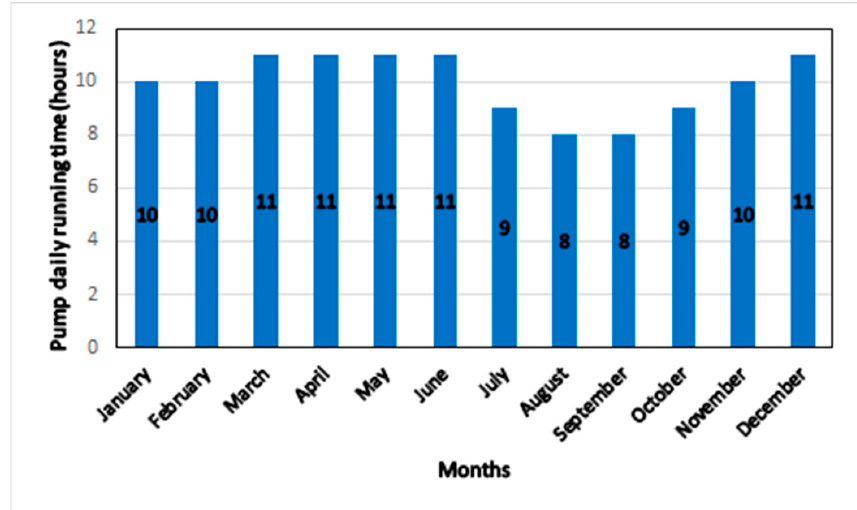
Figure 9. Pump daily running time.